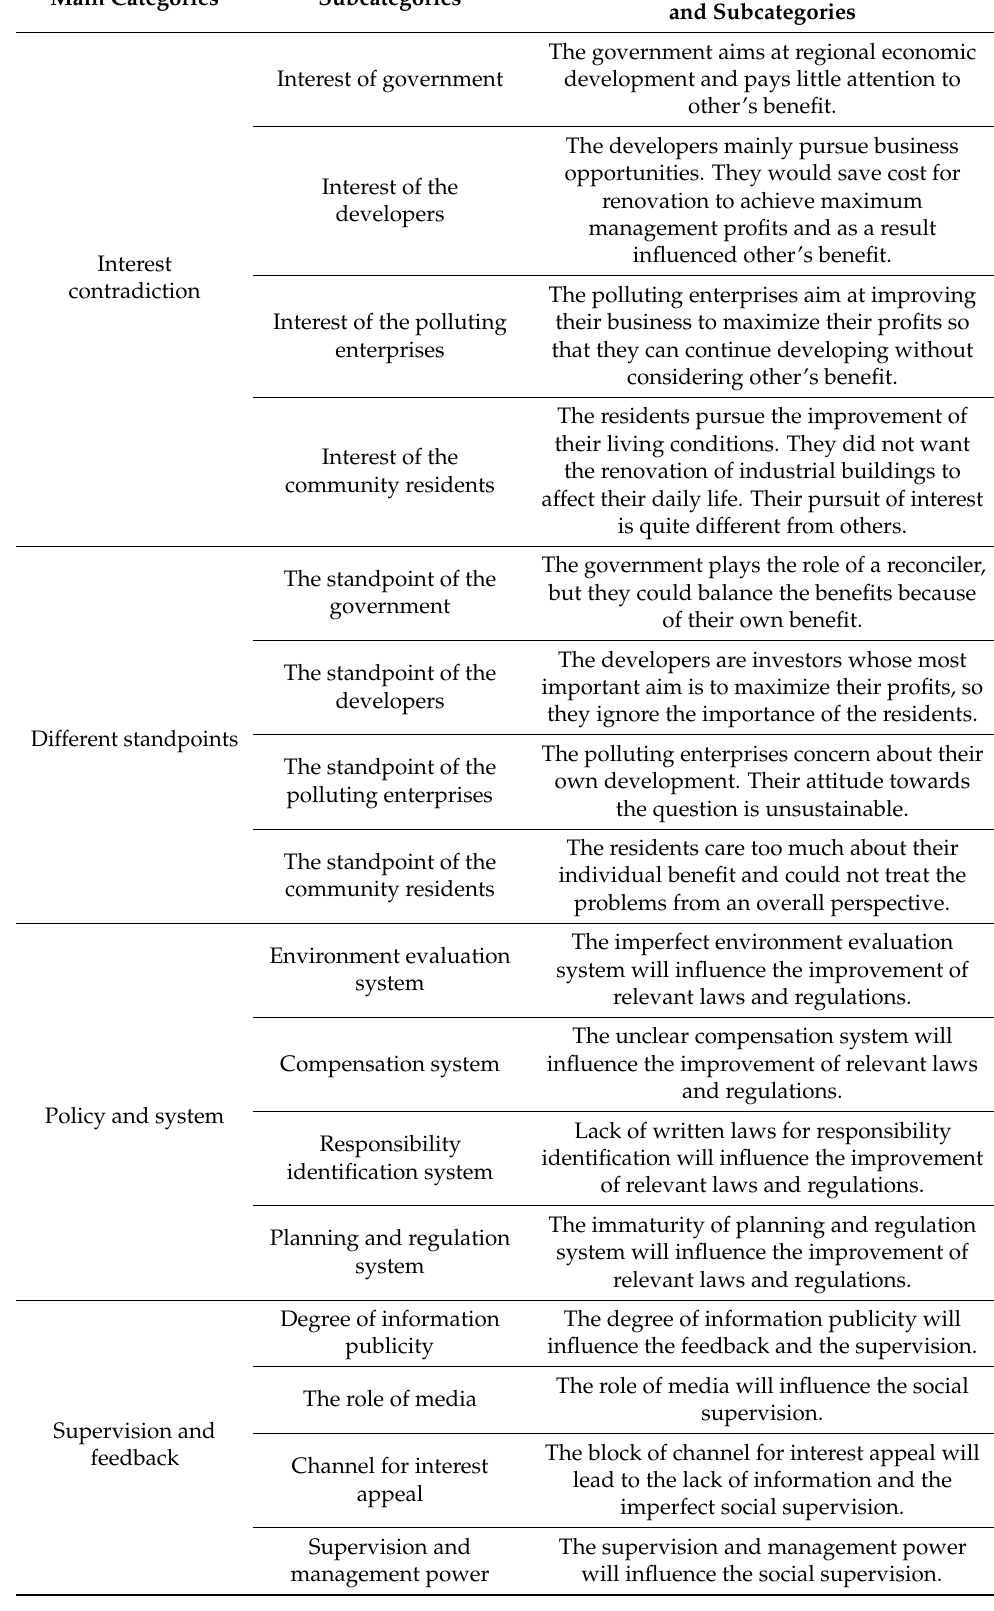
Table 3. The process for principal axis